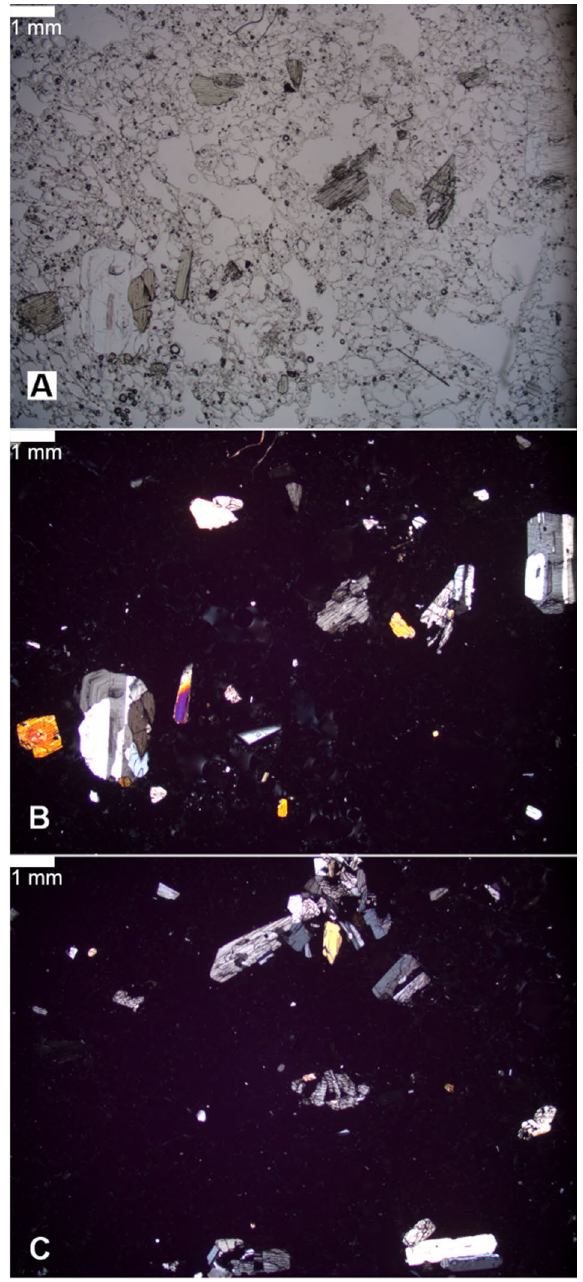
Figure 5. Photomicrographs of the 2019 Late’iki lava. ( A ) Plane polarised light view showing abundant, scattered pyroxene phenocrysts and highly vesicular glass. ( B , C ) Cross-polarised views showing polymineralic glomeroporphyritic textures, complexly zoned plagioclase and zoning in some pyroxene phenocrysts. Scale bar is 1 mm in all